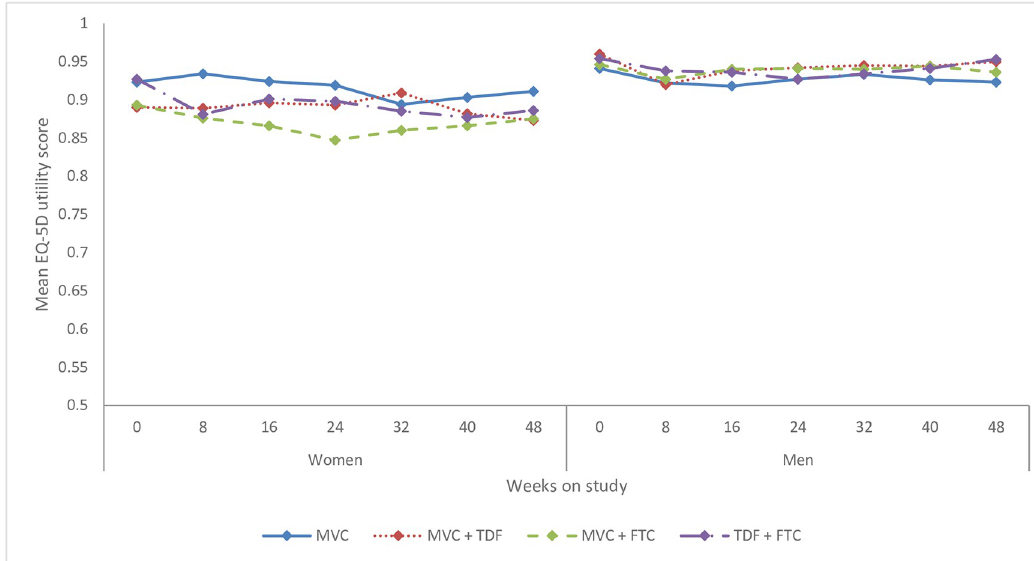
Fig 1. Mean EQ-5D utility (Quality of life) score by PrEP study regimen over time. Legend: Mean utility measured by EQ-5D, converted to health utility using U.S. valuation weights, where 0 is equivalent to death and 1 to perfect health. MVC = maraviroc, TDF = tenofovir disoproxil fumarate, FTC = emtricitabine.